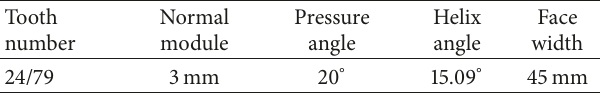
Table 1: Basic gear